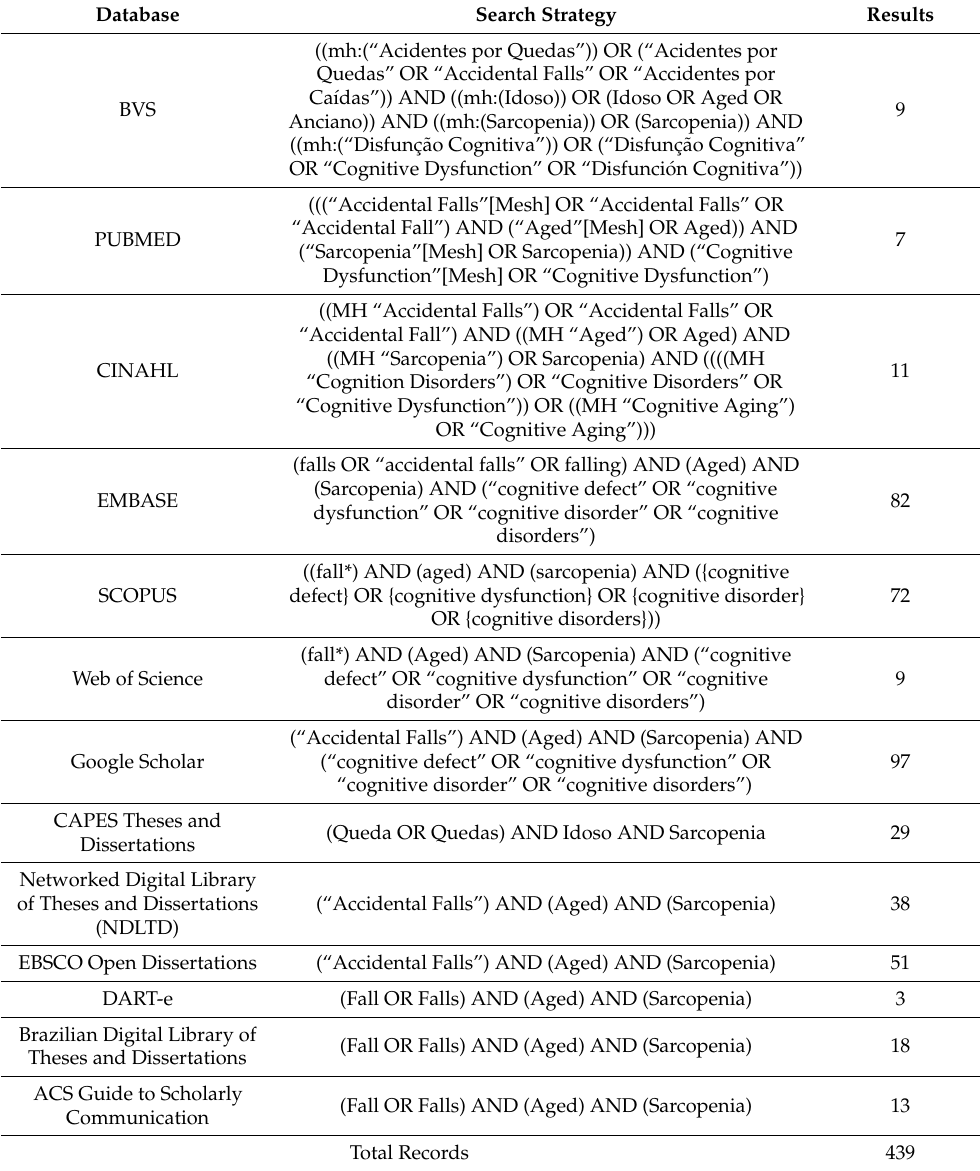
Table 1. Search strategy in the various databases, S ã o Paulo, SP, Brazil,